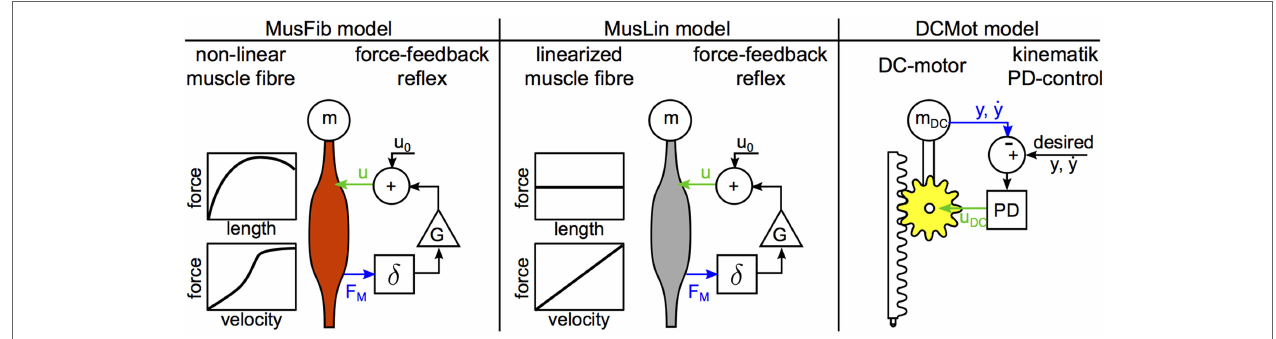
FIGURE 2 | Hopping models . The MusFib model considers the non-linear contraction dynamics of active muscle fibers and is driven by a mono-synaptic force-feedback reflex. The MusLin model only differs in the contraction dynamics, where the force-length relation is neglected and the force-velocity relation is approximated linearly. The DCMot model generates the leg force with a DC motor. It is controlled by a proportional-differential controller (PD), enforcing the desired trajectory. The desired trajectory is the recorded trajectory from the MusFib Model. The sensor signals are shown as blue arrows, and the actuator control signals are shown as green arrows. In case of the muscle models, the sensor signal is the muscle force F M , and the actuator control signal is the neural muscle stimulation u . In case of the DC-motor model, the sensor signals are the position and velocity of the mass, and the actuator control signal is the motor armature voltage u DC .